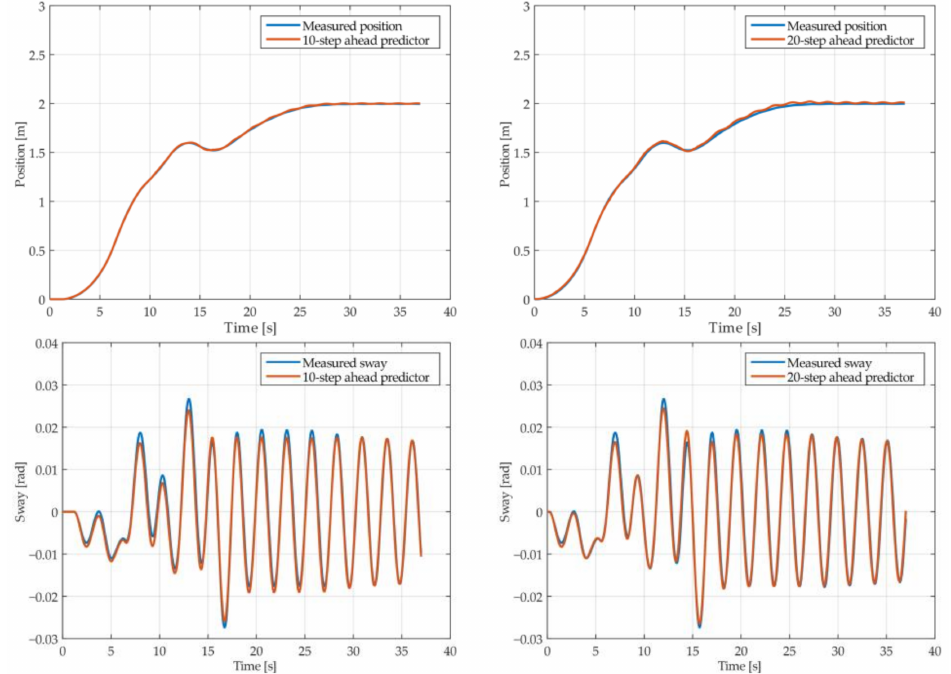
Figure 6. The 10- and 20-step ahead prediction with the MGGP model of the simulated crane position and payload sway with 0.9 m rope length and 40 kg payload